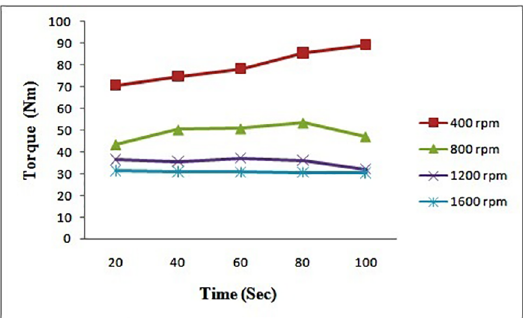
Figure 5 . Torque on the welds with water head of 10 mm at the rotational speed rates of 400, 800, 1200 and 1600 rpm